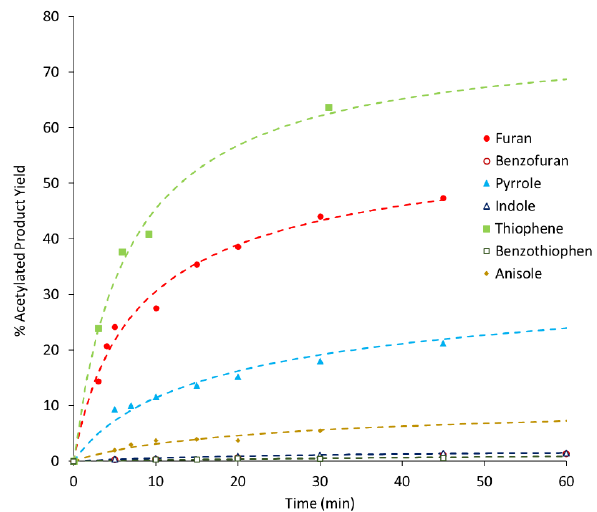
Figure 2. Product yield as a function of reaction time using BEA-D as the catalyst (the dashed curves represent calculated values resulting from the application of the kinetic model).